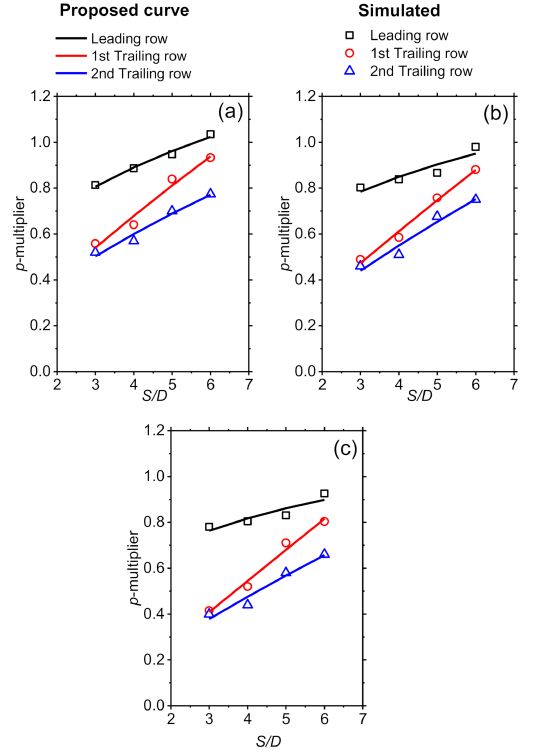
Figure 5. Regression between calculated p -multipliers vs. S/D for various rows for free-head condition: ( a ) ϕ = 30 ◦ , ( b ) ϕ = 35 ◦ , and ( c ) ϕ = 40 ◦ .